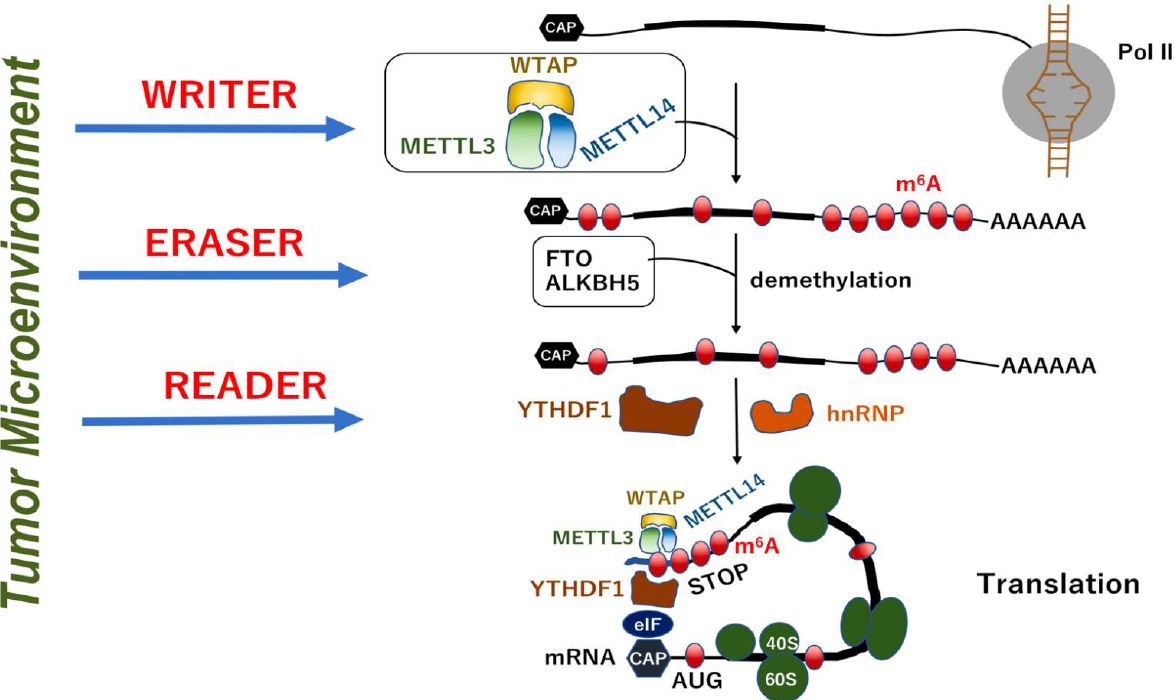
Figure 2. RNAs and their related molecules in human diseases. RNA polymerase-dependent synthesis and modification of mRNAs are modulated in response to the IBD microenvironment. The “writer” proteins (METTL3, METTL14, and WTAP) play a role in mRNA methylation, whereas the “eraser” proteins (FTO and ALKBH5) are involved in the removal of m 6 A methylation marks. These m 6 A marks are interpreted by “reader” proteins, such as Ythdf1, which functions in the peptide translation of mRNAs. This system plays a role in the control of peptide translation in epithelial and immune cells in IBD.